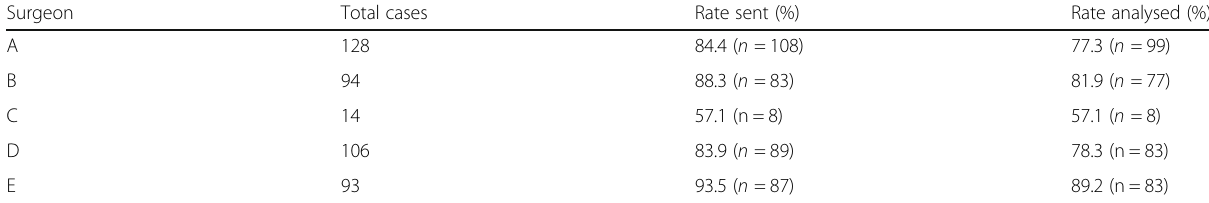
Table 3 Variation in individual surgeon practice